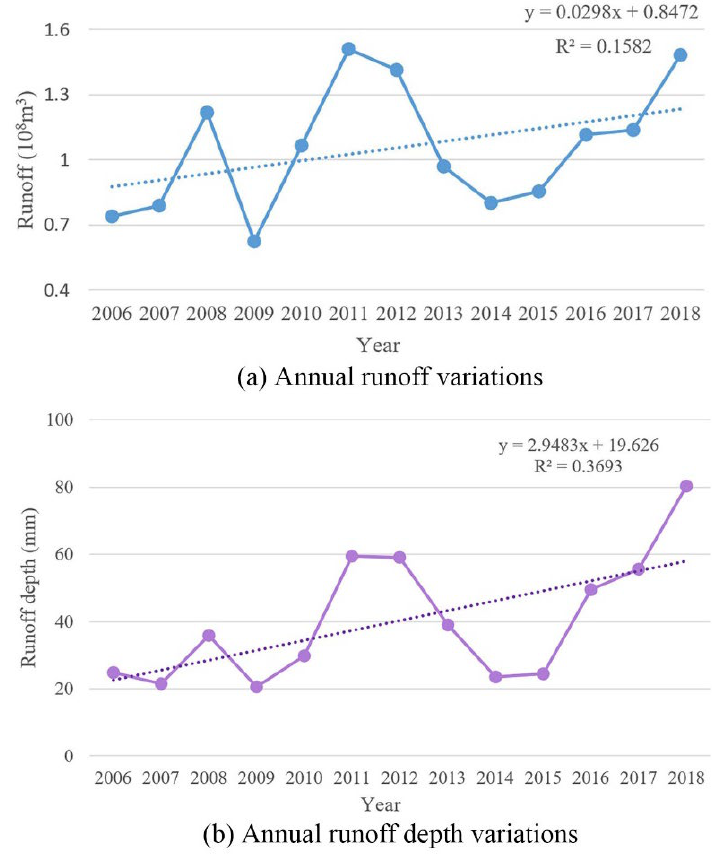
Figure 2. Annual variations of runoff and runoff depth.